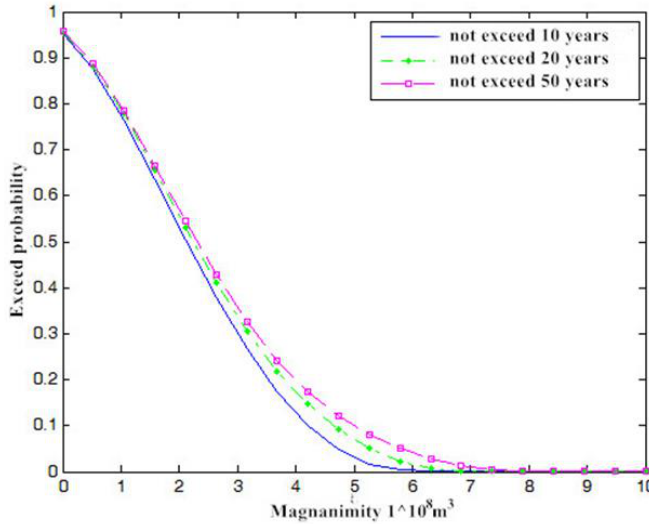
Figure 7. Flood volume exceedance when peak flow is less than a certain return period.